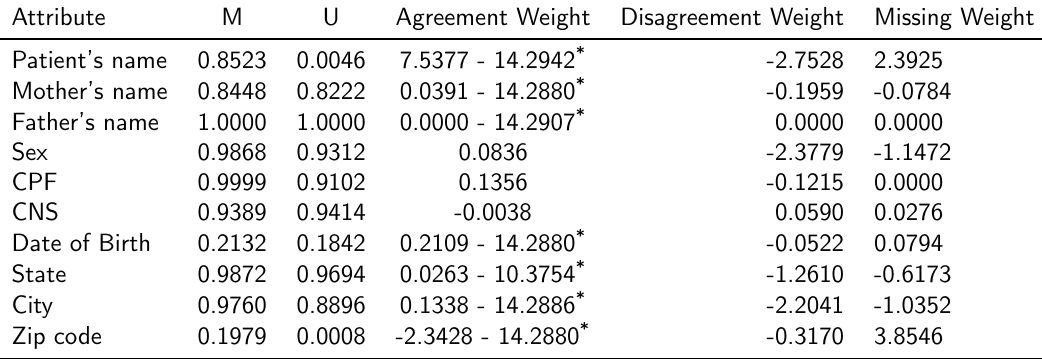
Table 2: Values of m and u , and respective weights of agreement and disagreement, for the probabilistic deduplication of records. Attribute M U Agreement Weight Disagreement Weight Missing Weight